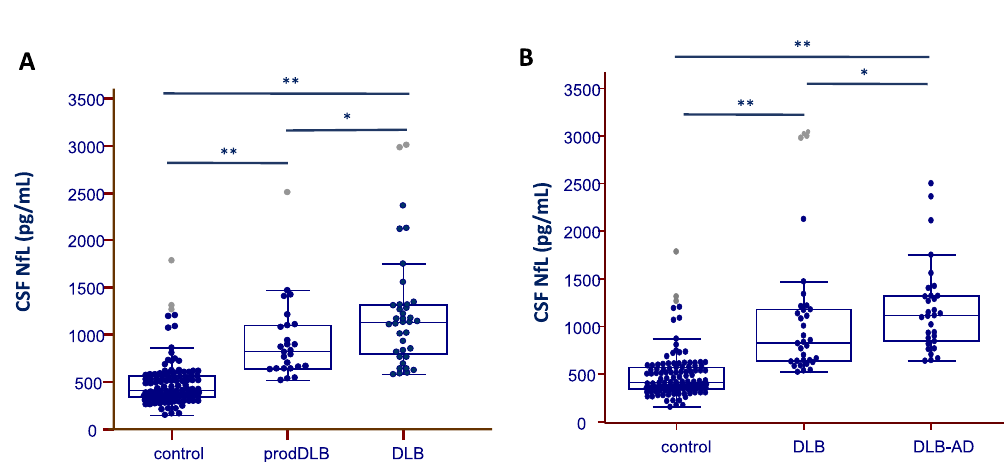
Figure 3. CSF Neurofilament light (NfL) protein levels in patients with Dementia with Lewy Bodies (DLB). ( A ) Box and whisker plots of the median concentrations of CSF NfL in control participants and patients with Dementia with Lewy Bodies (DLB) or prodromal DLB (prodDLB). The central black lines show the median values, regions above and below these lines show the upper and lower quartiles, respectively. Outliers (indicated with grey circles) are defined as a value that is larger than the upper quartile plus three times the interquartile range. ( B ) Box and whisker plots of the median concentrations of CSF NfL in control participants and patients with Dementia with Lewy Bodies (DLB) and DLB with AD pathology AD (DLB-AD). The central black lines show the median values, regions above and below these lines show the upper and lower quartiles, respectively. Outliers (indicated with grey circles) are defined as a value that is larger than the upper quartile plus three times the interquartile range. * p < 0.05, ** p <